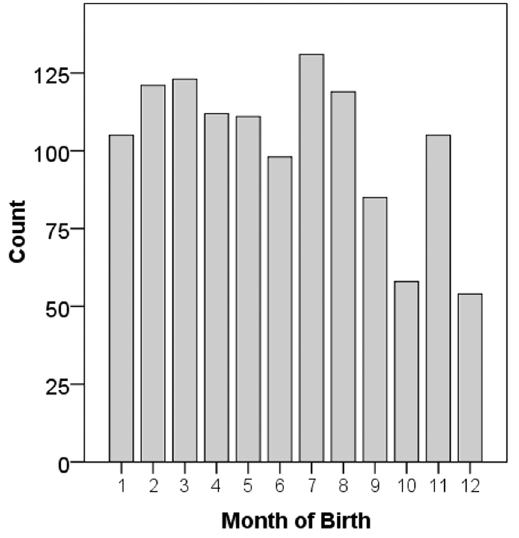
Figure 1. Distribution of spherical equivalents in the right eye.